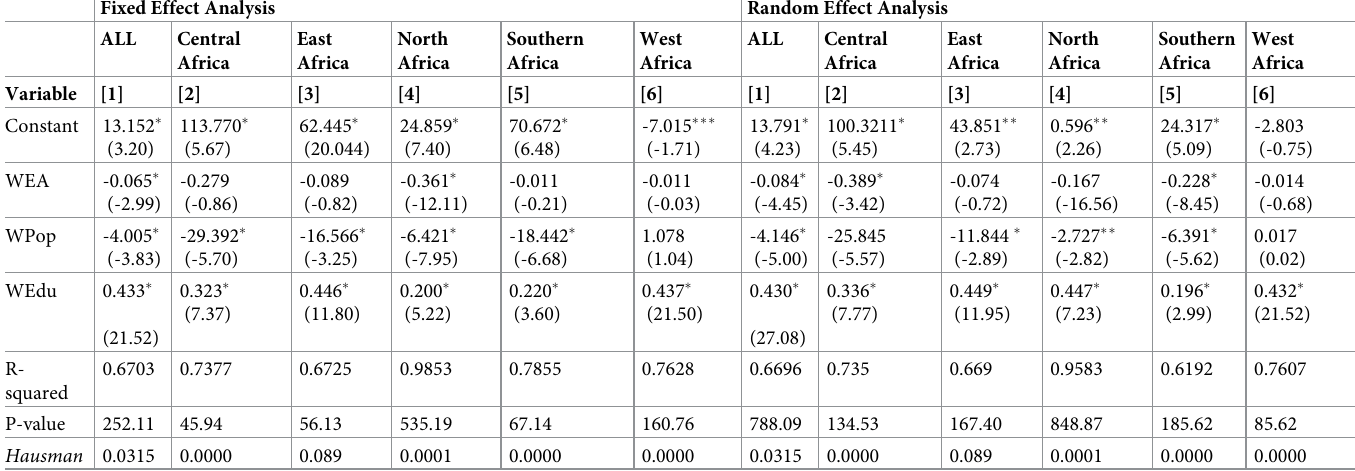
Table 4. Fixed and random effects